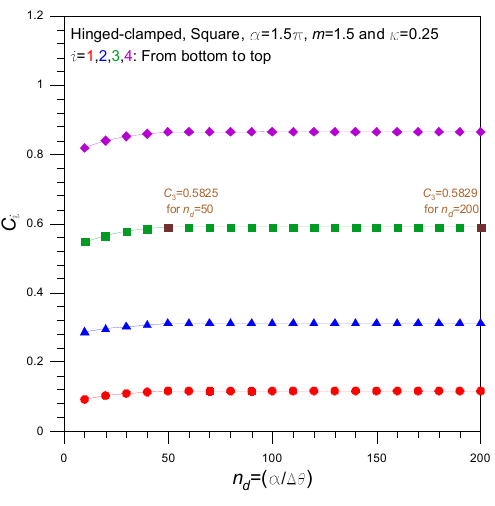
Figure 5. Convergence analysis.